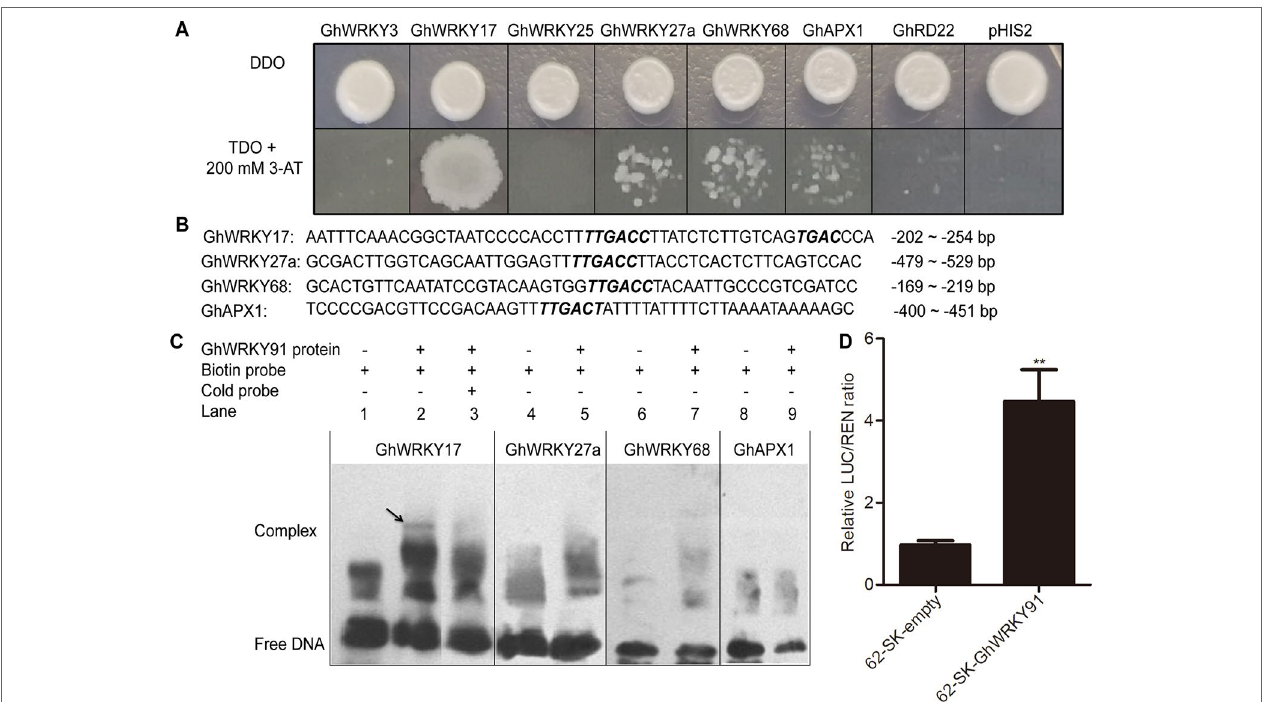
FIGURe 7 | GhWRKY91 directly targets the promoter of GhWRKY17 and trans-activates GhWRKY17 expression. (a) Interaction between GhWRKY91 and the promoters of candidate target genes GhWRKY3 , GhWRKY17 , GhWRKY25 , GhWRKY27a , GhWRKY68 , GhAPX1, and GhRD22 in Y1H system. The combination of pGADT7-GhWRKY91 and pHIS2 plasmids was used as a negative control. (B) Probe sequences of GhWRKY17 , GhWRKY27a , GhWRKY68, and GhAPX1 for the EMSA assays. (C) Binding of GhWRKY91 to the W-boxes in the promoters of GhWRKY17 , GhWRKY27a , GhWRKY68, and GhAPX1 in EMSA assays. '–' indicates absence, while '+' indicates presence. (D) GhWRKY91 trans-activates GhWRKY17 promoter in transient dual-luciferase reporter system. The LUC/REN ratio of the combination of pGreenII-62-SK empty vector and GhWRKY17 promoter was set as 1. The data are the means ± SEs of six biological replicates. **P <